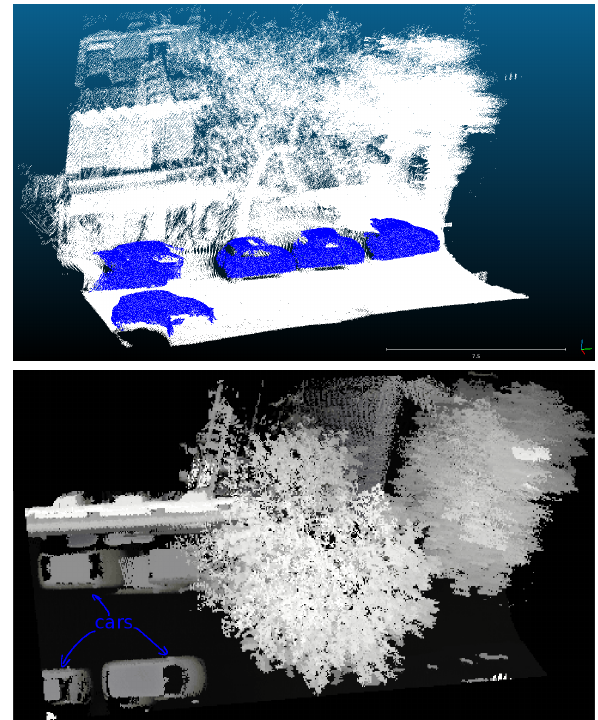
Figure 7: Example of situation where the method of (Serna and Marcotegui, 2014) does not allow to segment cars located under a tree. Up: 3D point cloud with cars well segmented (in blue), down: max elevation image of the same point cloud where cars located under the tree do not